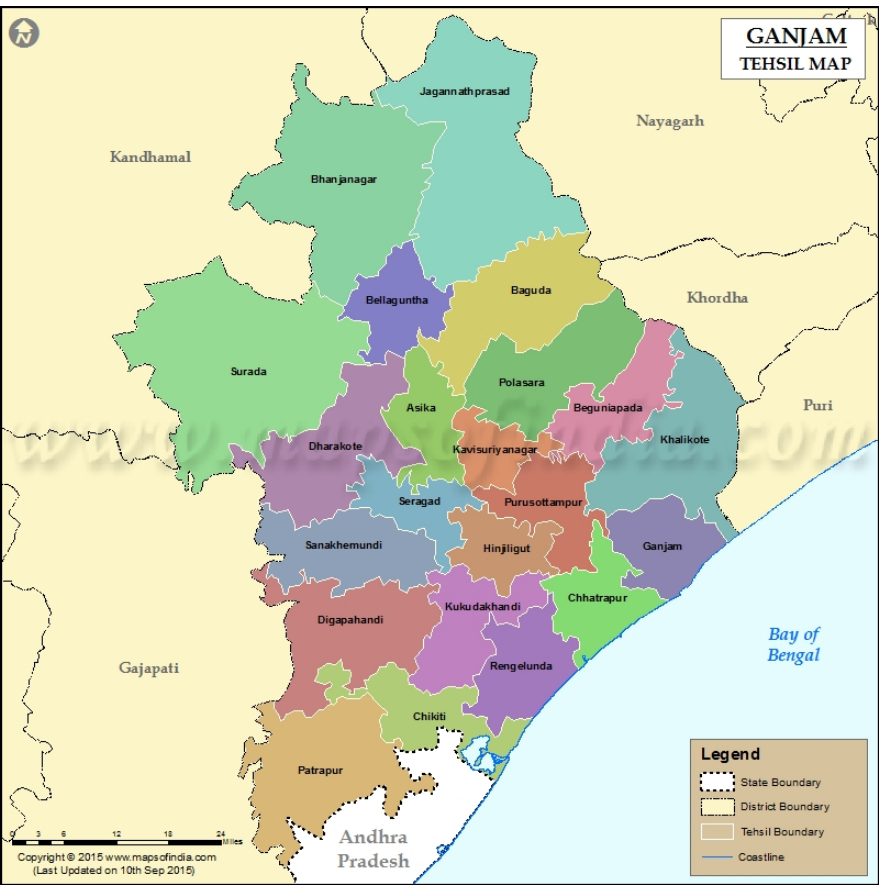
Figure 1. Ganjam Tehsil Map highlighting the names and locations of all the tehsils (administrative areas) in the district (https://www.mapsofindia.com/maps/orissa/tehsil/ganjam.html, accessed on 12 October 2022).